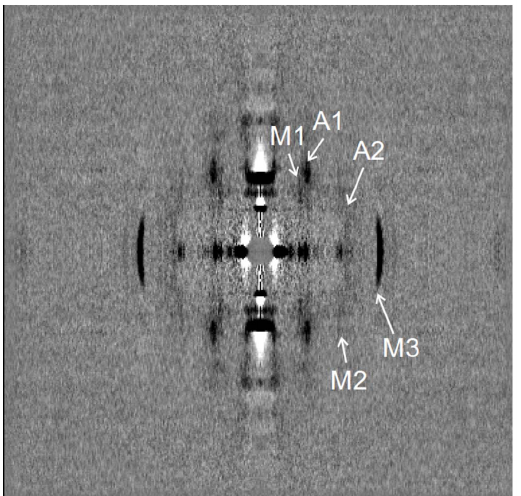
Figure 3. Low-angle X-ray diffraction. The difference between the diffraction patterns recorded during the isometric and the stretching phases, collected from 9 runs of the protocol in 5 bundles of muscle fibers in the first experimental series. The isometric pattern was subtracted from the pattern collected during stretch that had been multiplied by a factor of 1.035–1.059 to correct for the stretch-induced decrease in the fiber volume exposed to the x-rays. White and black correspond to an increase and decrease in the intensity during stretch compared to isometric contraction, respectively. X-ray reflections of interest are marked. Figure 4. Meridional profiles of the meridional (top) and off-